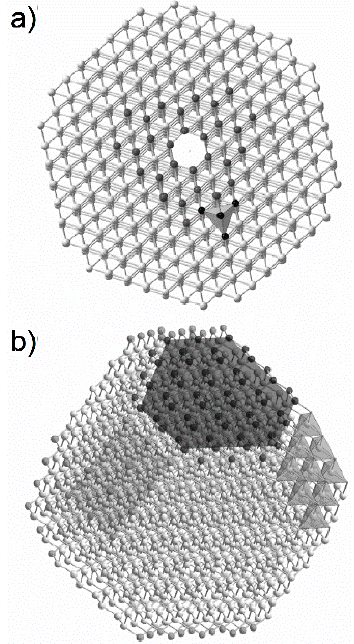
Figure 43. ( a ) Spherical and ( b ) truncated octahedron models of an explosive nanodiamond particle. The graphitic fragments are shown as black balls. Reproduced with permission from Hawelek et al. [144]. Copyright AIP Publishing, 2008.